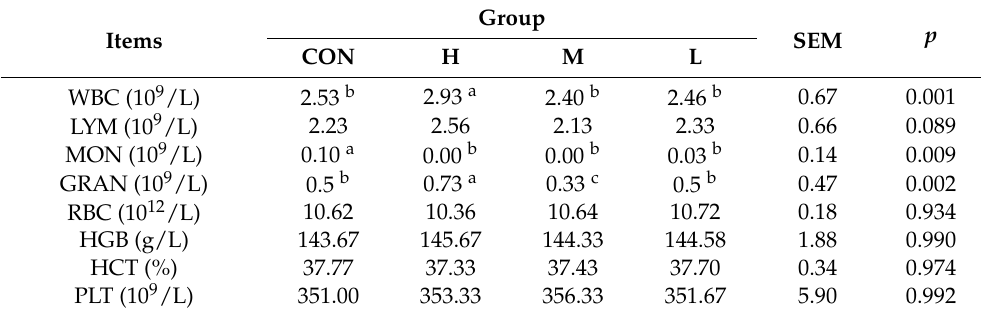
Table 4. Effects of ALE on blood routine in mice.